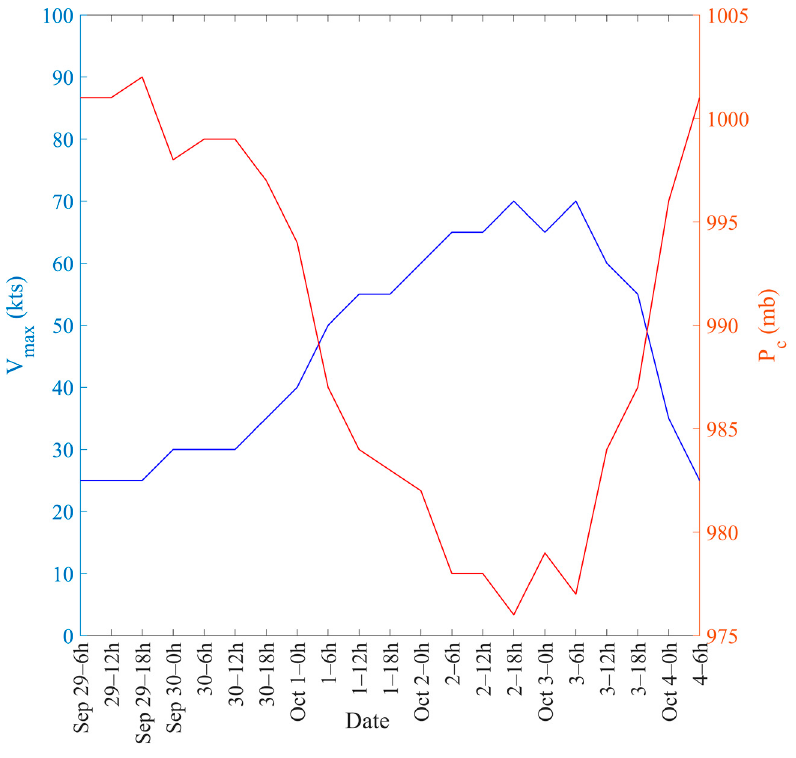
Figure 1. Extracted V max (blue line) and P c (red line) from JTWC during Cyclone Shaheen in the Arabian Sea.